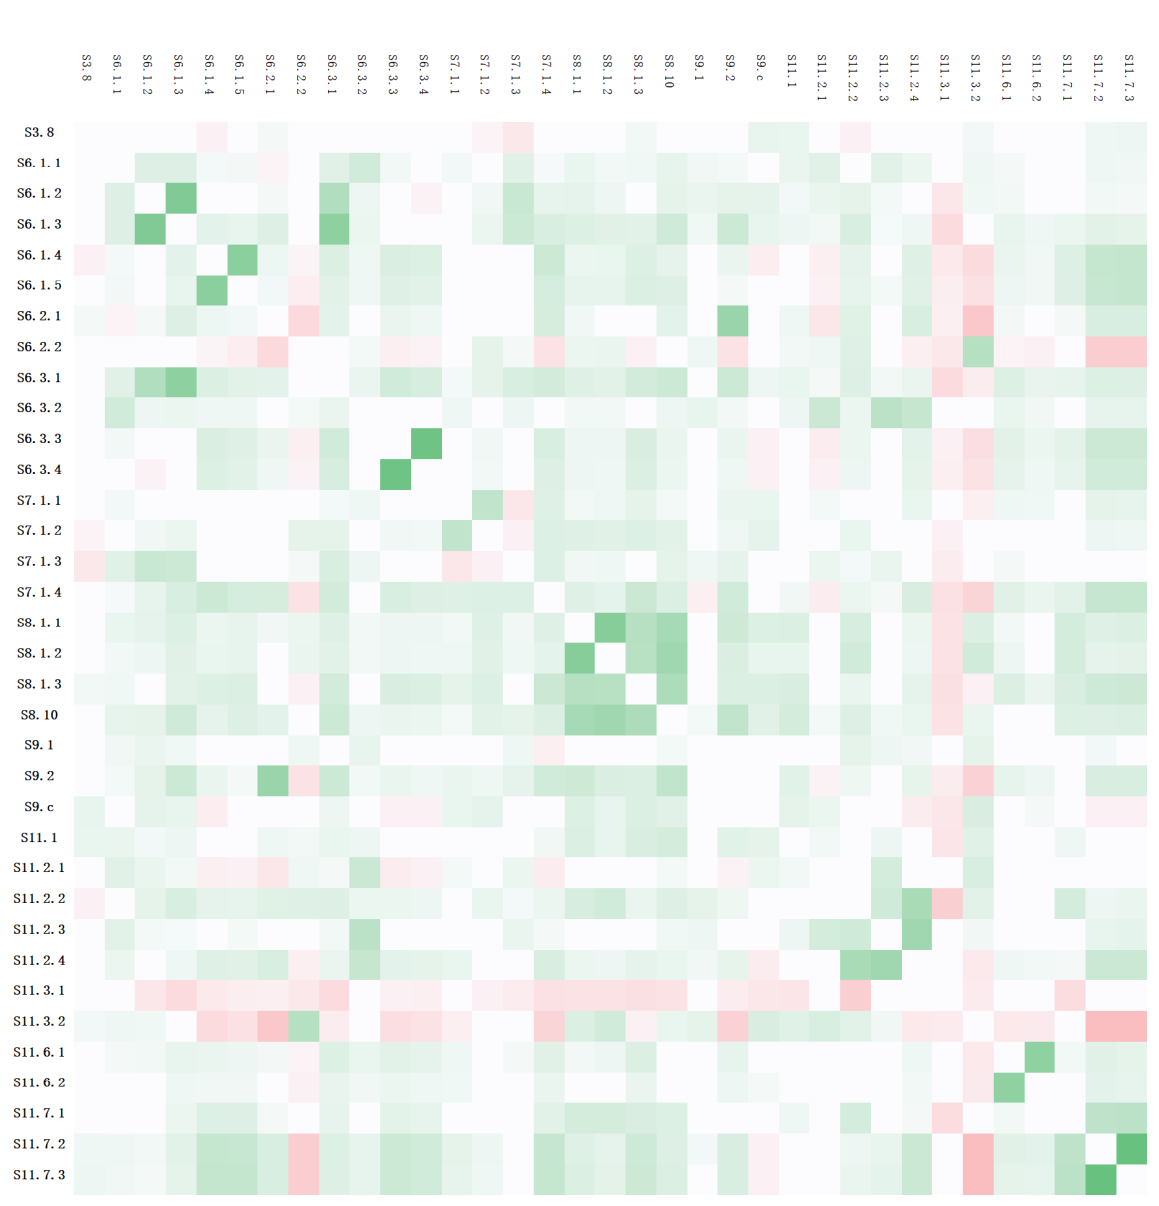
Figure 1. Correlation coefficient matrix.